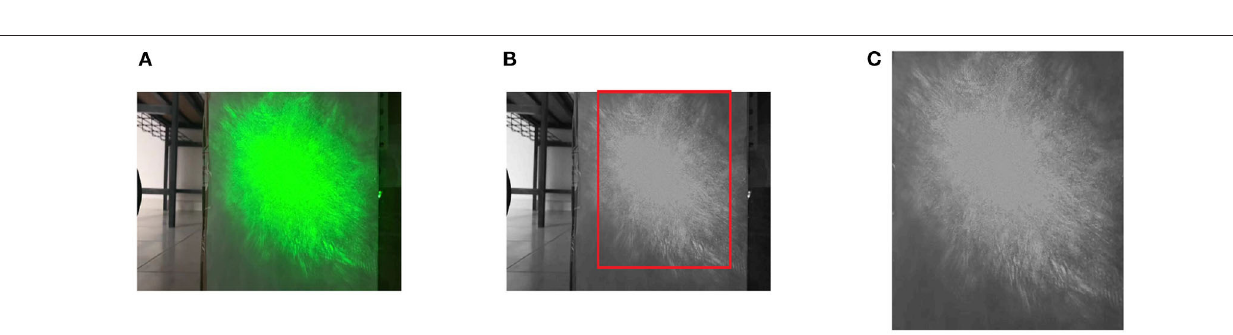
reaching a total mass of 33 kg and was used to propagate five pendulum impacts across it. All impacts were induced using a 0.575 kg mass at an initial angle θ = 30 ◦ with a pendulum